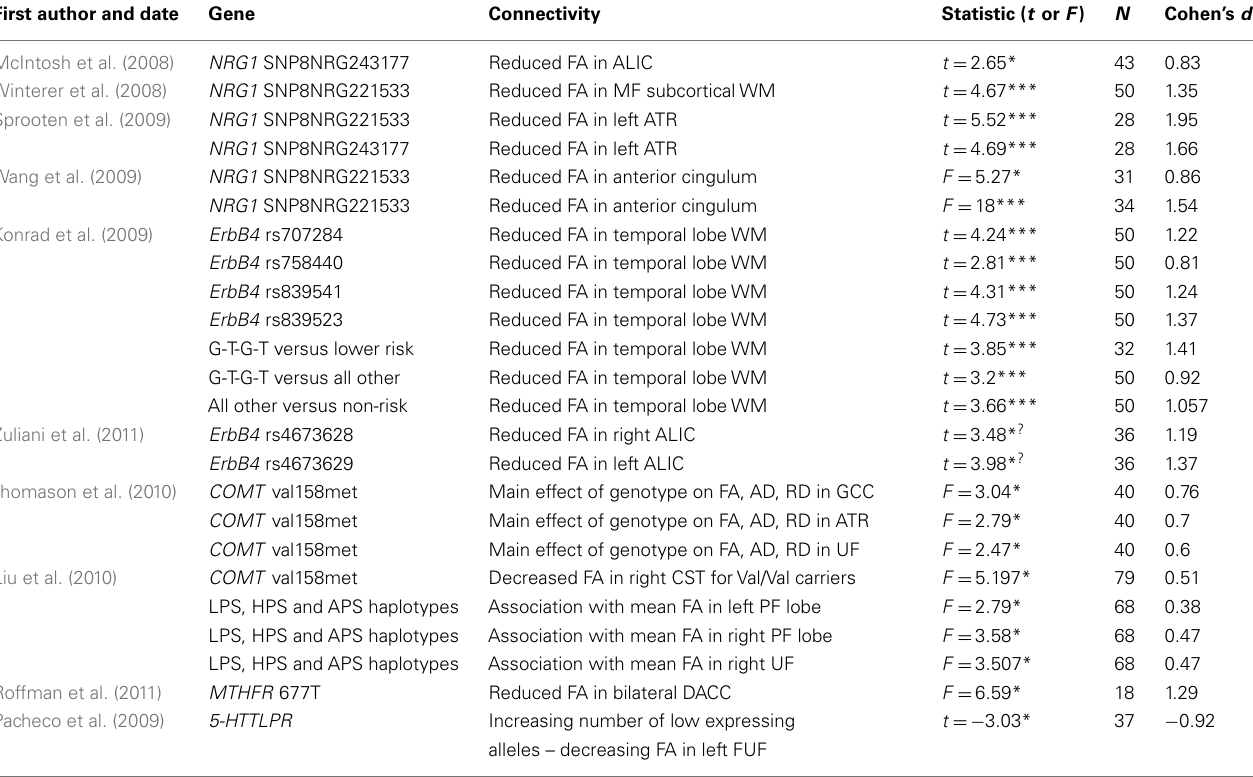
Table 2 | Details of the structural connectivity studies using DTI included in this